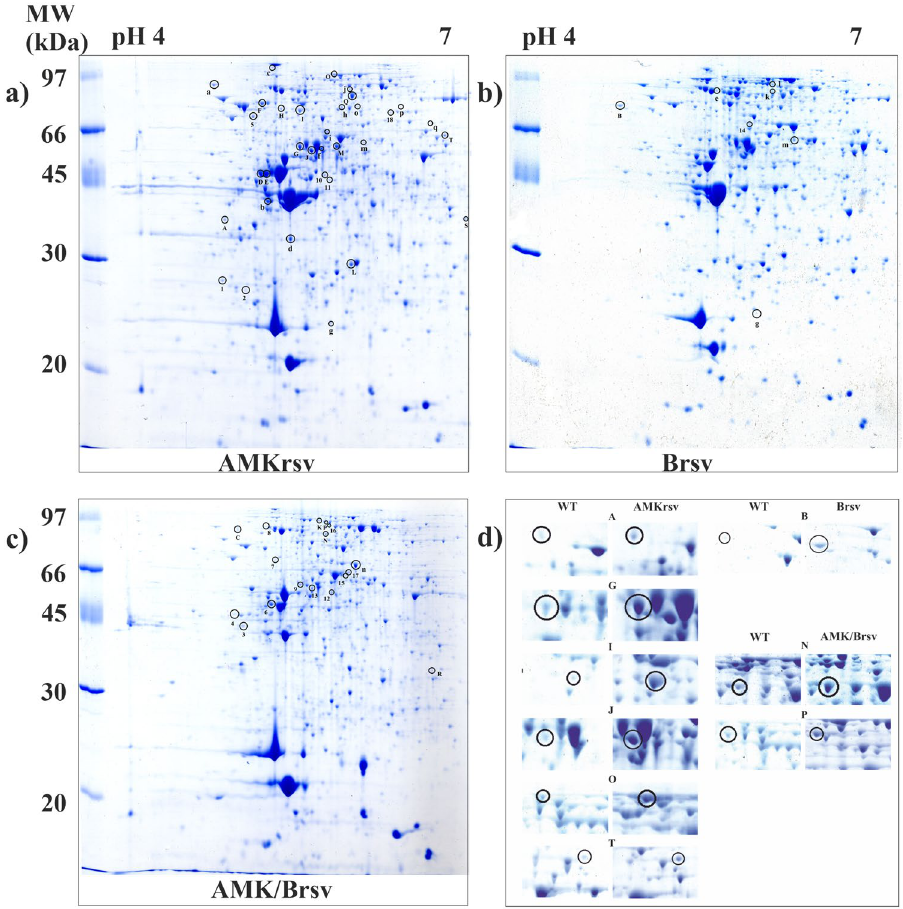
Figure 2. 2D profiles of OMPs Proteus mirabilis 3059: ( a ) amikacin resistant variant (AMKrsv), ( b ) bacteriophage resistant variant (Brsv), ( c ) amikacin and bacteriophage resistant variant (AMK/Brsv) and ( d ) magnified regions of selected overexpressed protein spots in the resistant variants. Proteins were stained with Coomassie Brilliant Blue G-250, gels were scanned using a Power-Look 1000 (UMAX Technologies Inc., Dallas, TX), and were analysed by PDQuest version 7.3.0 (Bio-Rad Laboratories). Spots marked with numbers indicate proteins which were detected only in studied resistant variants. Spots marked with capital letters or lowercase letters correspond to proteins with higher or lower level of expression in the resistant variants, respectively. Description of the proteins are included in Tables 2, 3,4. WT—wild type Proteus mirabilis 3059. Spots identification: A—elongation factor Tu [ Proteus vulgaris ]; B—transcription termination factor NusA; G— asparaginyl-tRNA synthetase; I—aspartyl-tRNA synthetase; J—ATP-dependent protease ATP-binding subunit HslU; N—ClpA protein; O—polyphosphate kinase; P—flagella basal body rod protein; T—glycerol-3-phosphate